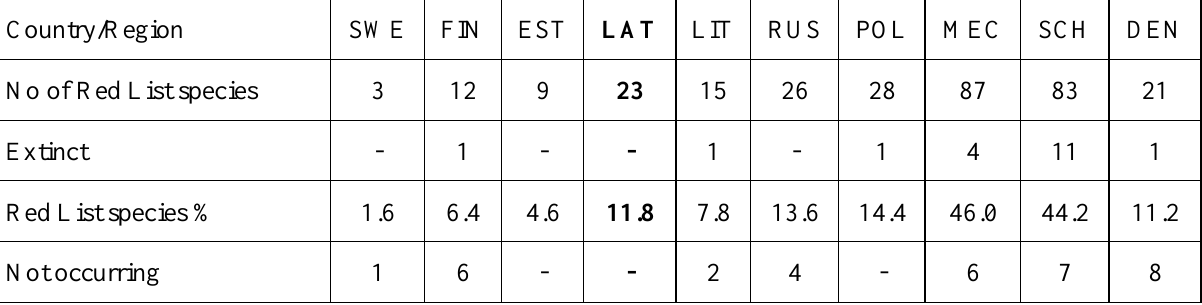
Table 1. Vascular plant and bryophyte flora of the Slītere National Park mires in relation to their Red List status in the countries of the Baltic catchment area. Country codes: SWE – Sweden; FIN – Finland; EST – Estonia; LAT – Latvia; LIT – Lithuania; RUS – North-western Russia; POL – Poland; MEC – Mecklenburg- Vorpommern (Germany); SCH – Schleswig-Holstein (Germany); DEN – Denmark.